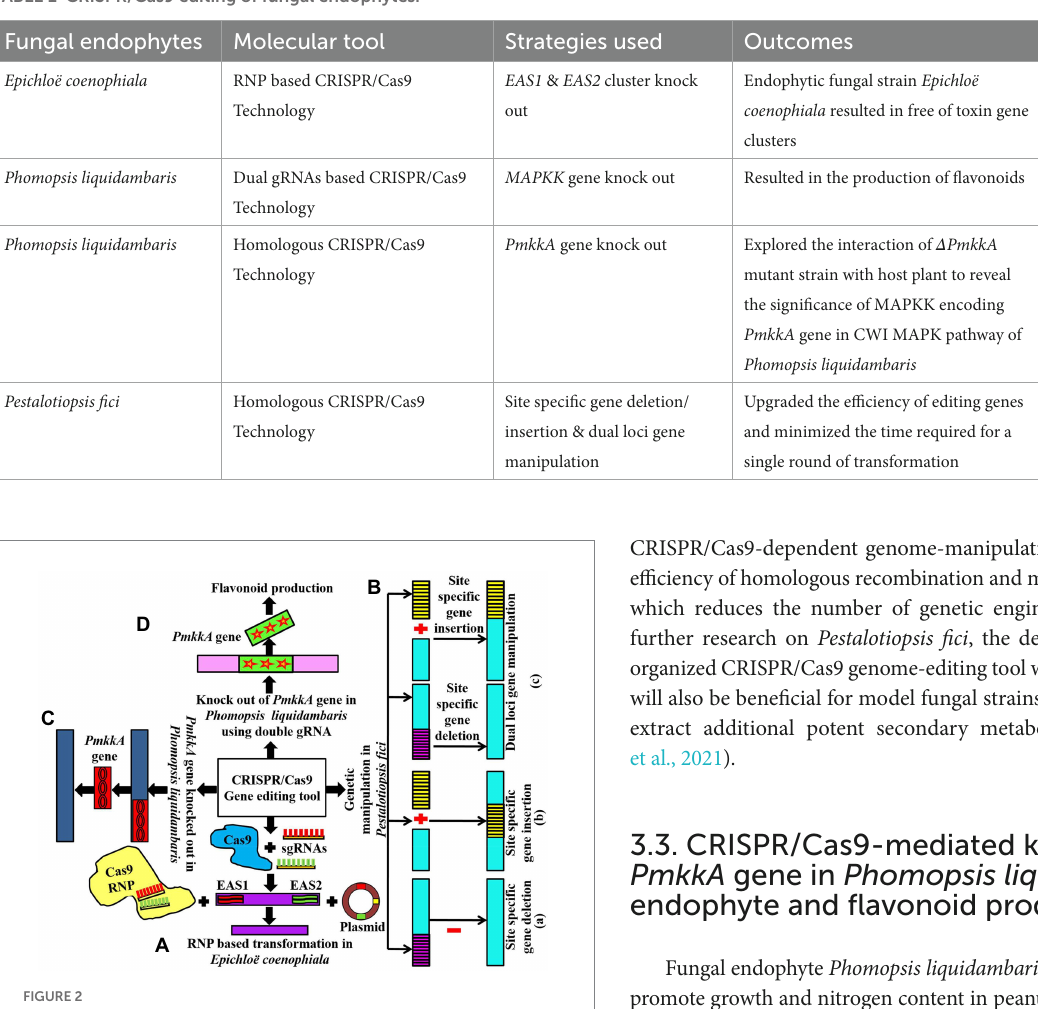
TABLE 1 CRISPR/Cas9 editing of fungal endophytes.